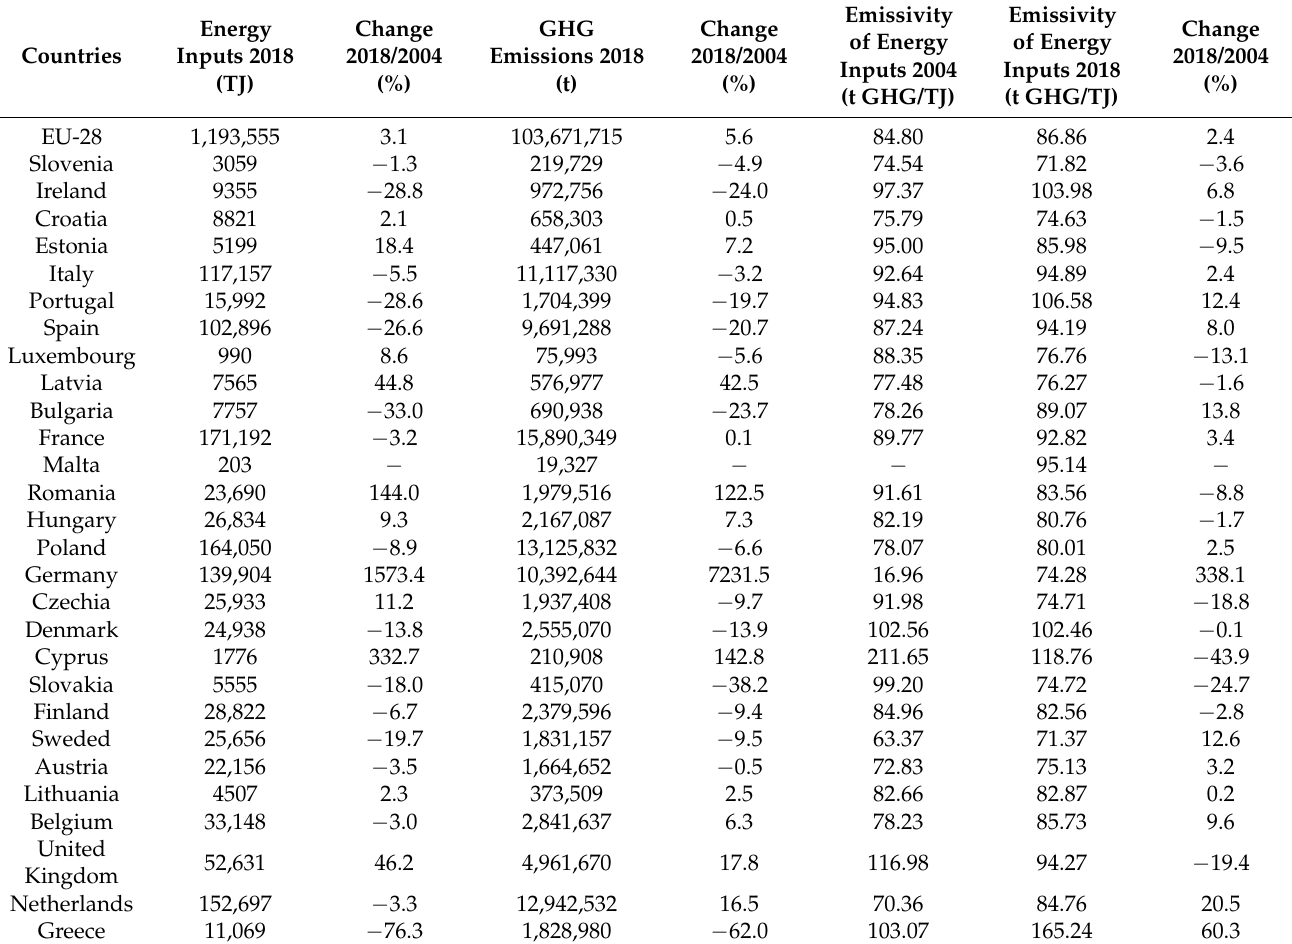
Table 6. GHG emission from energy inputs in agriculture in the EU countries in